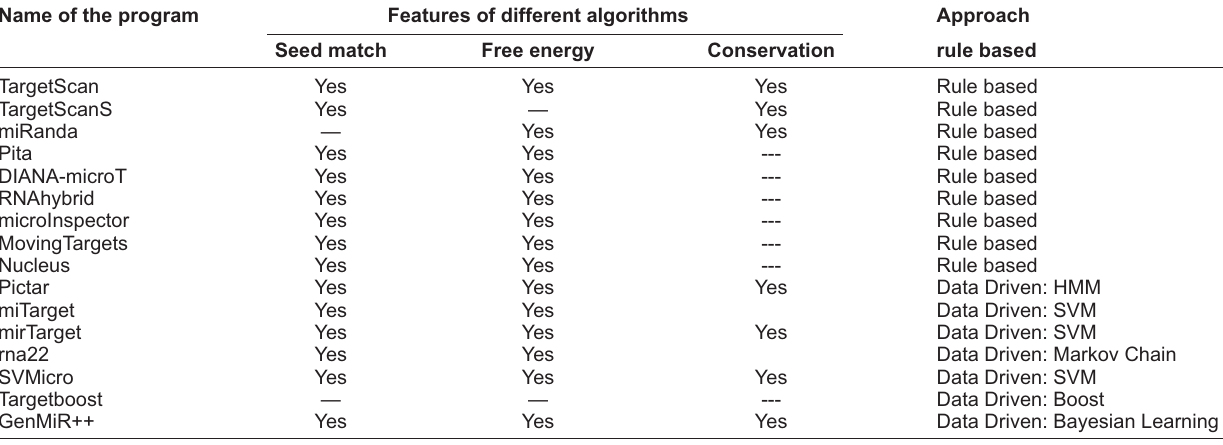
Table-1. Features of miRNA target prediction algorithms [44]. Name of the